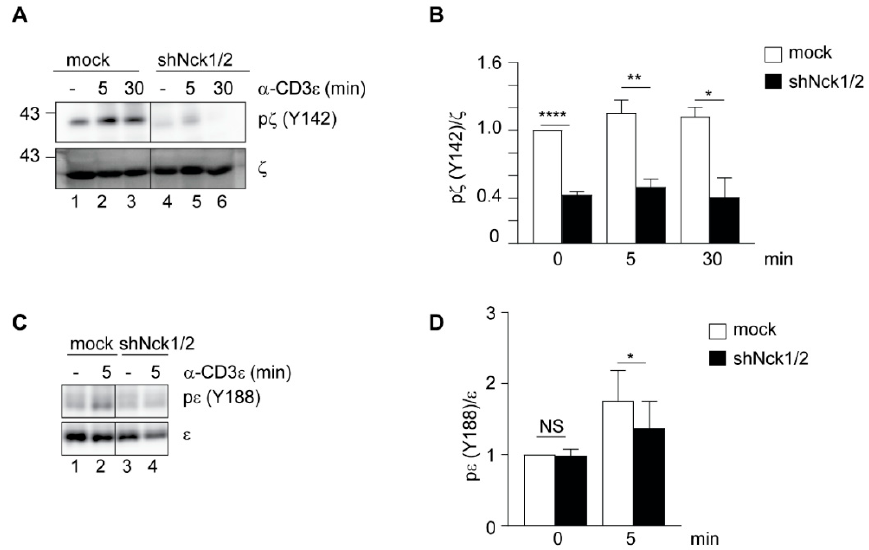
Figure 2. TCR phosphorylation depends on the presence of Nck. ( A ) Cells were left unstimulated (-) or stimulated with 1 µg/mL anti-CD3 ε antibody (OKT3) at the indicated times at 37 °C. Total cell lysates were subjected to immunoblot with anti-phospho- ζ (Y142) and anti- ζ antibodies. ( B ) Data from three independent experiments performed as in A were pooled and unpaired Student’s t -test was performed between the indicated samples. ( C ) Cells were stimulated as in A. Total cell lysates were subjected to TCR-immunoprecipitation and immunoblotting with anti-phospho- ε (Y188) and anti- ε antibodies. ( D ) Data from three independent experiments performed as in C were pooled and paired Student’s t -test was performed between the indicated samples. Mean values ± SEM are shown. * p < 0.05, ** p < 0.01, p **** < 0.0001, NS, not significant.